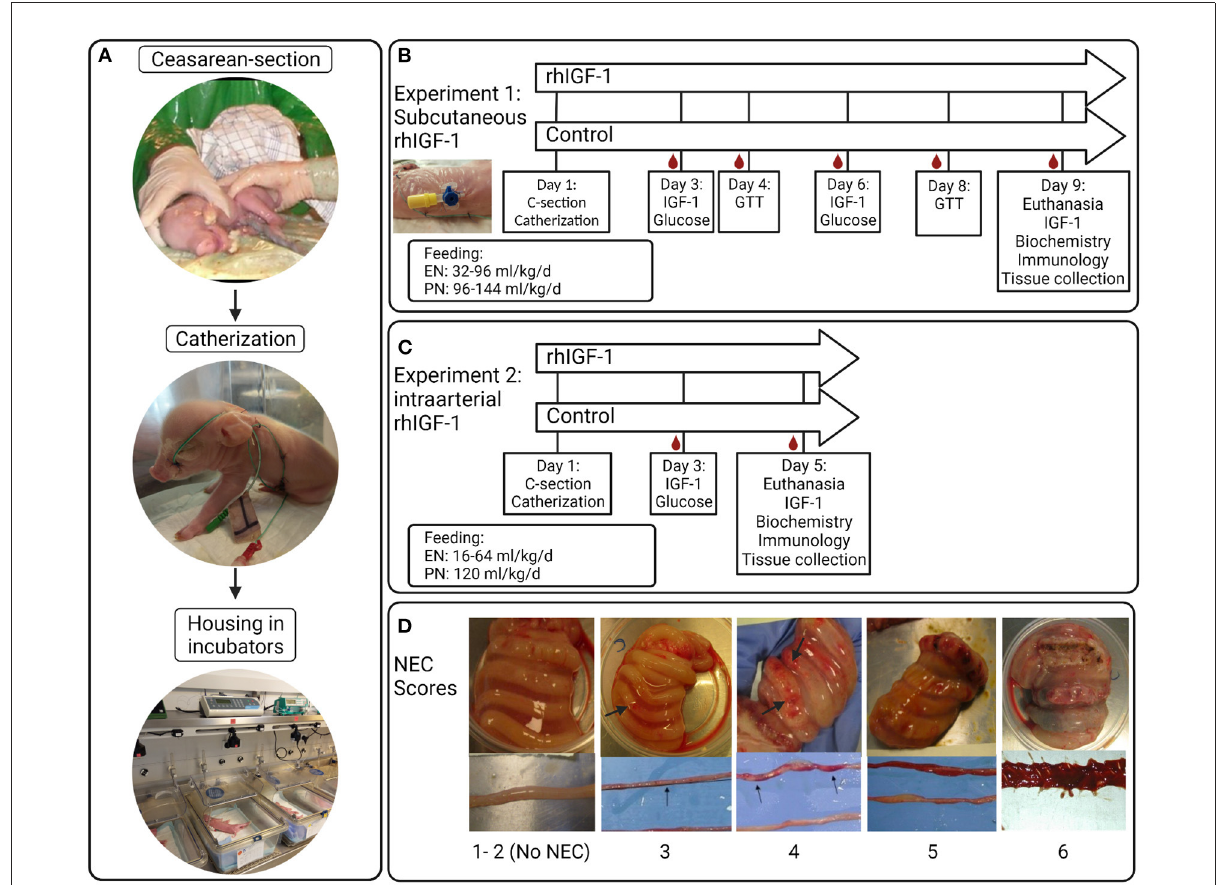
FIGURE1 Overview of study procedures, experimental design and NEC scores for small intestine and colon. (A) Preterm pigs are delivered by cesarean section, resuscitated and fitted with an orogastric feeding tube and umbilical artery catheter. Pigs are supplemented parenteral nutrition to meet energy requirements and housed individually in heated incubators. (B) Blood sampling, injections and feeding regimens in Experiment 1 with subcutaneous rhIGF-1 administration. (C) Blood sampling, injections and feeding regimens in Experiment 2 with intra-arterial rhIGF-1 administration. (D) Examples of small intestinal and colonic tissues with NEC scores 1-6; 1 = absence of lesions, 2 = local hyperaemia, 3 = hyperaemia, extensive edema and local hemorrhage, 4 = extensive hemorrhage, 5 = local necrosis or pneumatosis intestinalis, 6 = extensive necrosis and pneumatosis intestinalis. Note the hemorrhagic lesions (arrows). rhIGF-1, recombinant human insulin-like growth factor-1; IGF-1, insulin-like growth factor-1; GTT, glucose tolerance test; NEC, necrotizing enterocolitis. The figure was created using